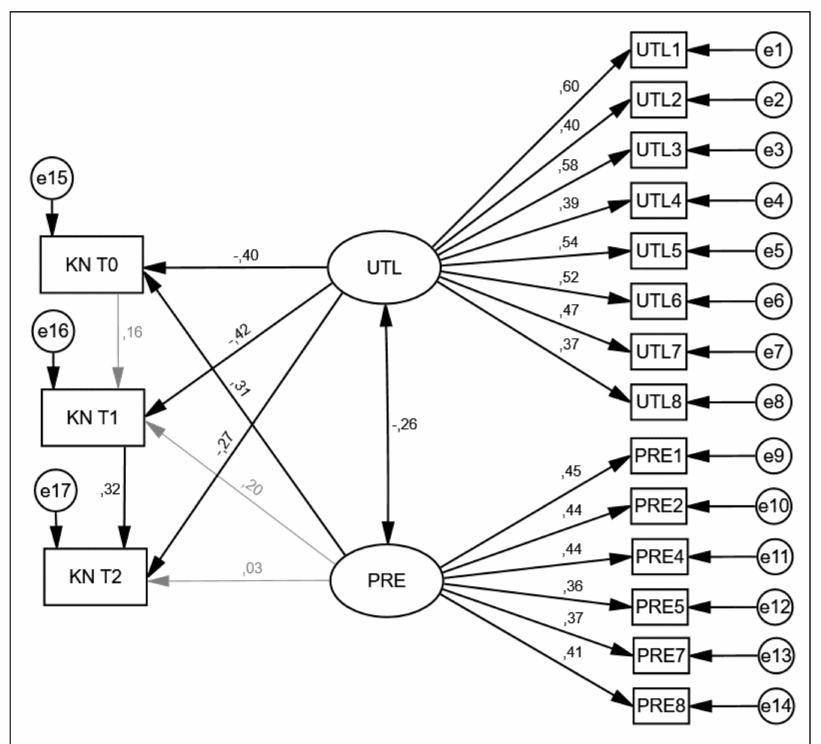
Figure 3. Path analysis model. Fit indices: χ 2 = 132.01, df = 113, χ 2/df = 1.17, p = 0.107, CFI = 0.947, RMSEA = 0.027. Explained variance in the criterion variables are 32% in KNT0 (R 2 = 0.32), 37% in KNT1 (R 2 = 0.37) and 28% in KNT2 (R 2 = 0.28). Grey arrows represent insignificant relations ( p > 0.05). e =